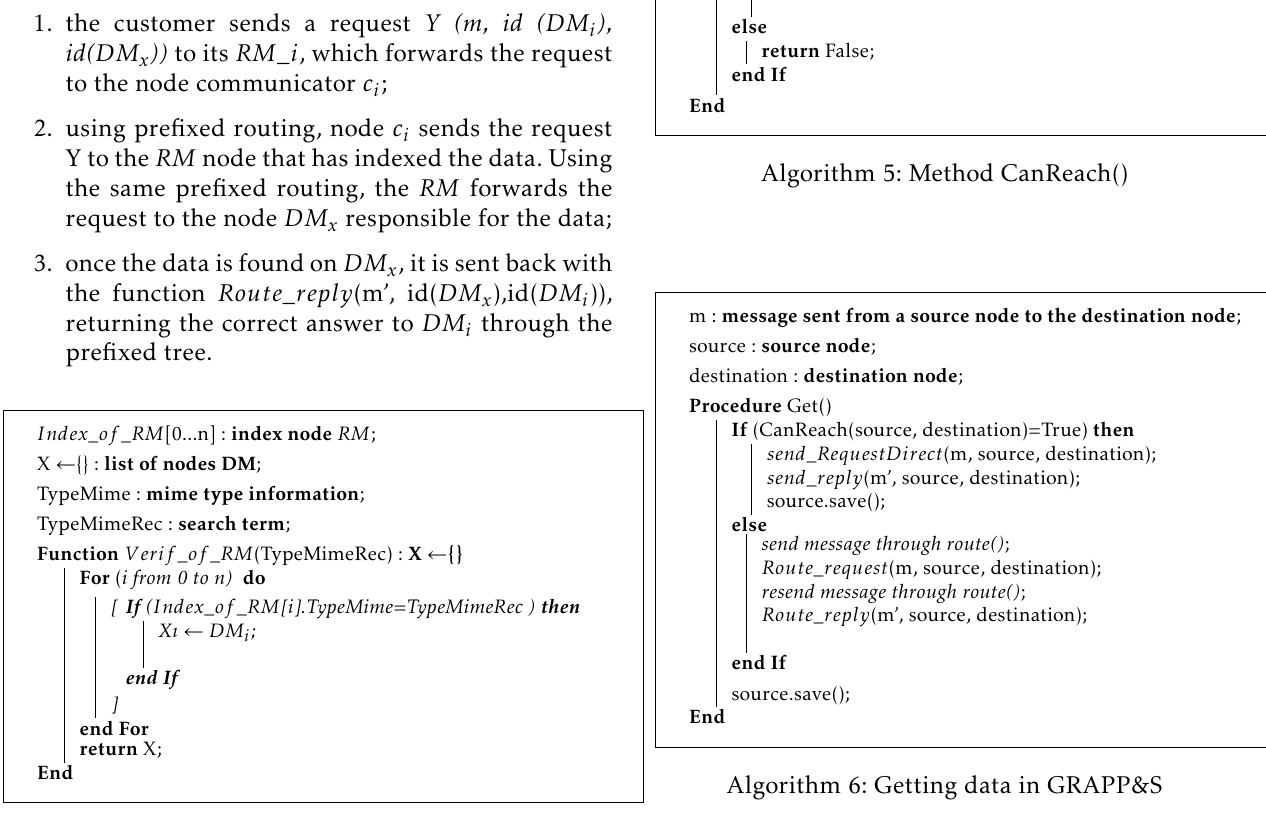
Algorithm 2: Checking indexes RM